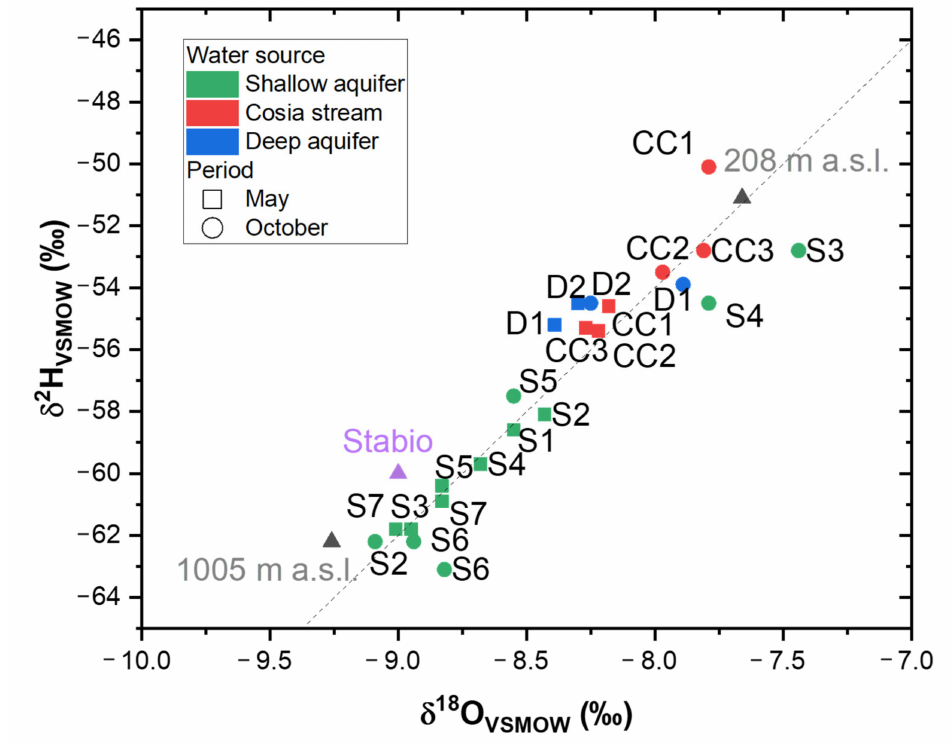
Figure 6. Isotope plot of the Cosia Creek, the shallow and the deep aquifer samples, sampled in May and October 2015. Shaded line indicates the equation of the Global Meteoric water line and 2 points of rain stations in Northern Italy (Andalo for 1005 m a.s.l. and Darfo Boario for 208 m a.s.l., respectively;